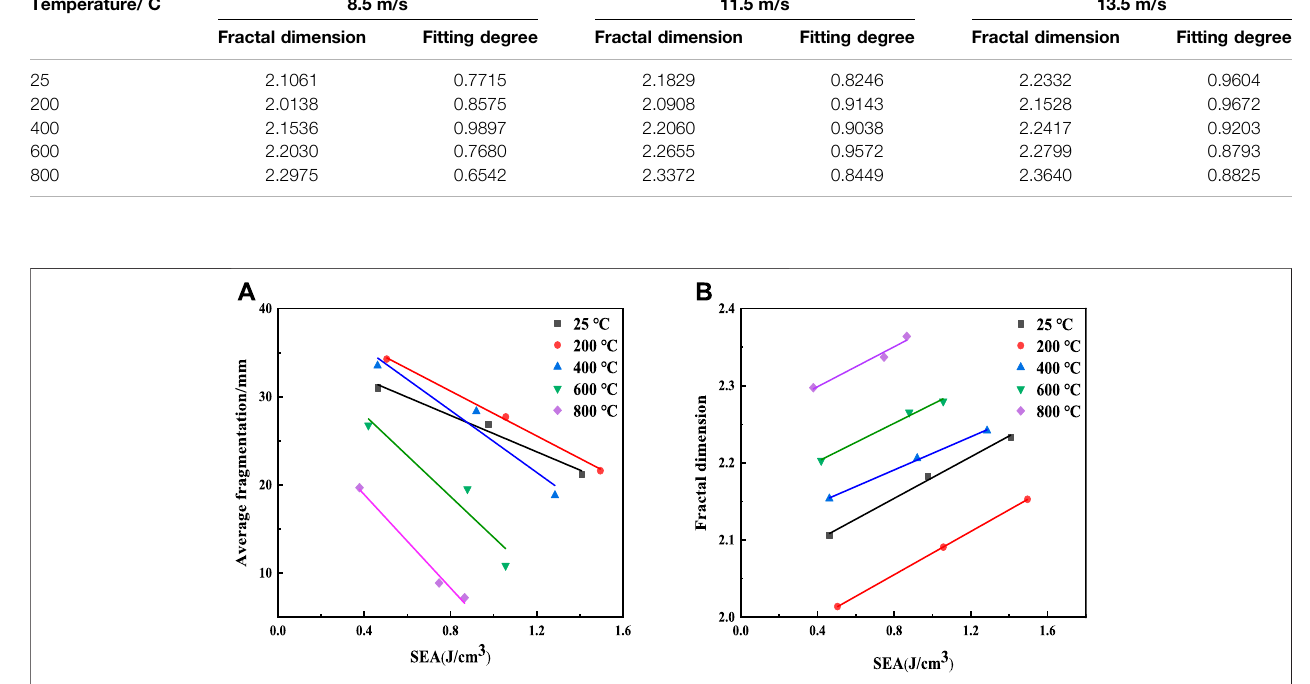
FIGURE 10 | Relationship of (A) average fragmentation and (B) fractal dimensions with energy consumption density.